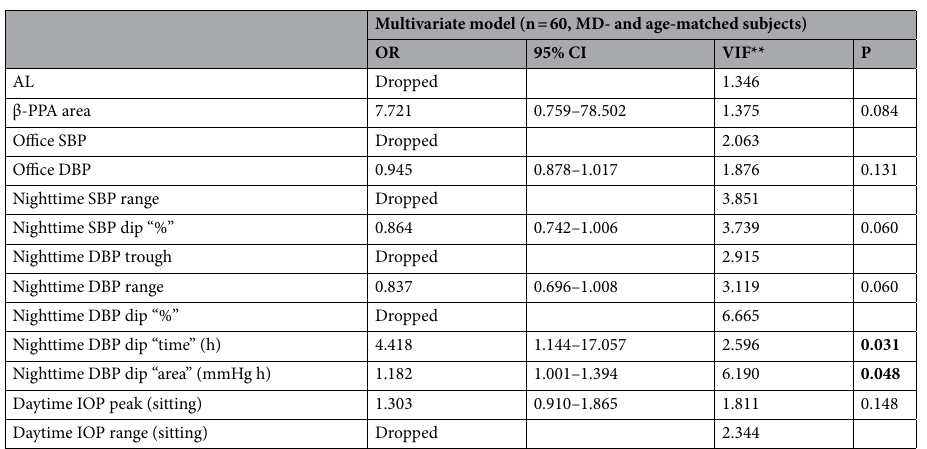
Multivariate model (n = 60, MD- and age-matched